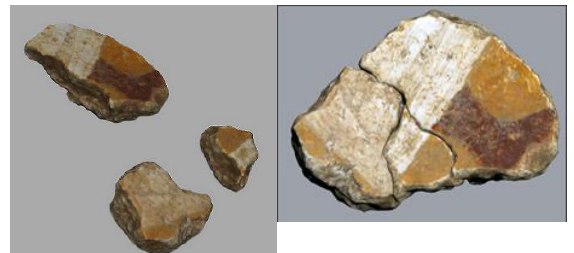
Figure 9: Manual digital reassembly of